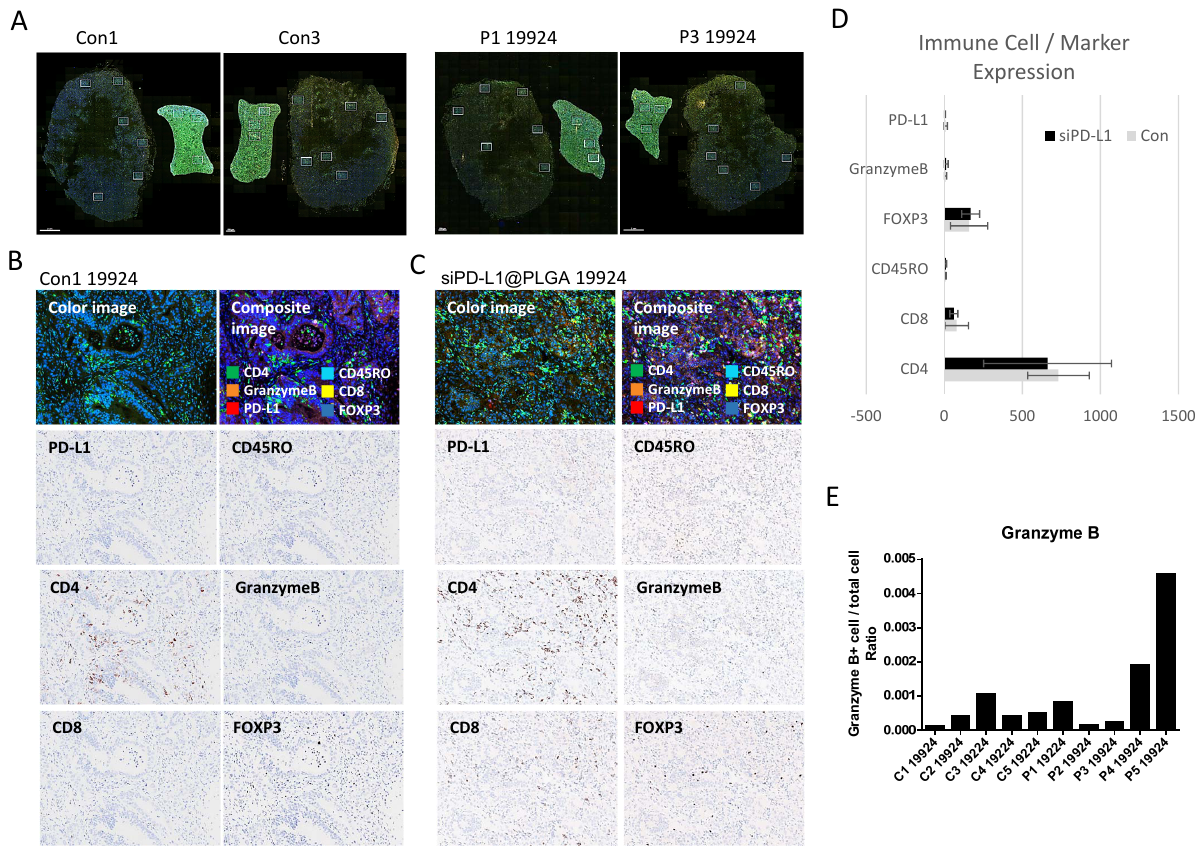
Figure 5. Multiplex immunohistochemistry analysis (OPAL) revealed that the tumor-immune microenvironment was modulated by siPD-L1@PLGA. ( A ) Representative whole tumor images for the control tumors (C1 and C3) or siPD- L1@PLGA-treated tumors (P1 and P3) from the humanized NSG mouse. ( B , C ) Specific IHC images of the control tumors ( B ) and siPD-L1@PLGA-treated tumors ( C ). PD-L1, CD45RO (Activated and memory T lymphocytes), CD4